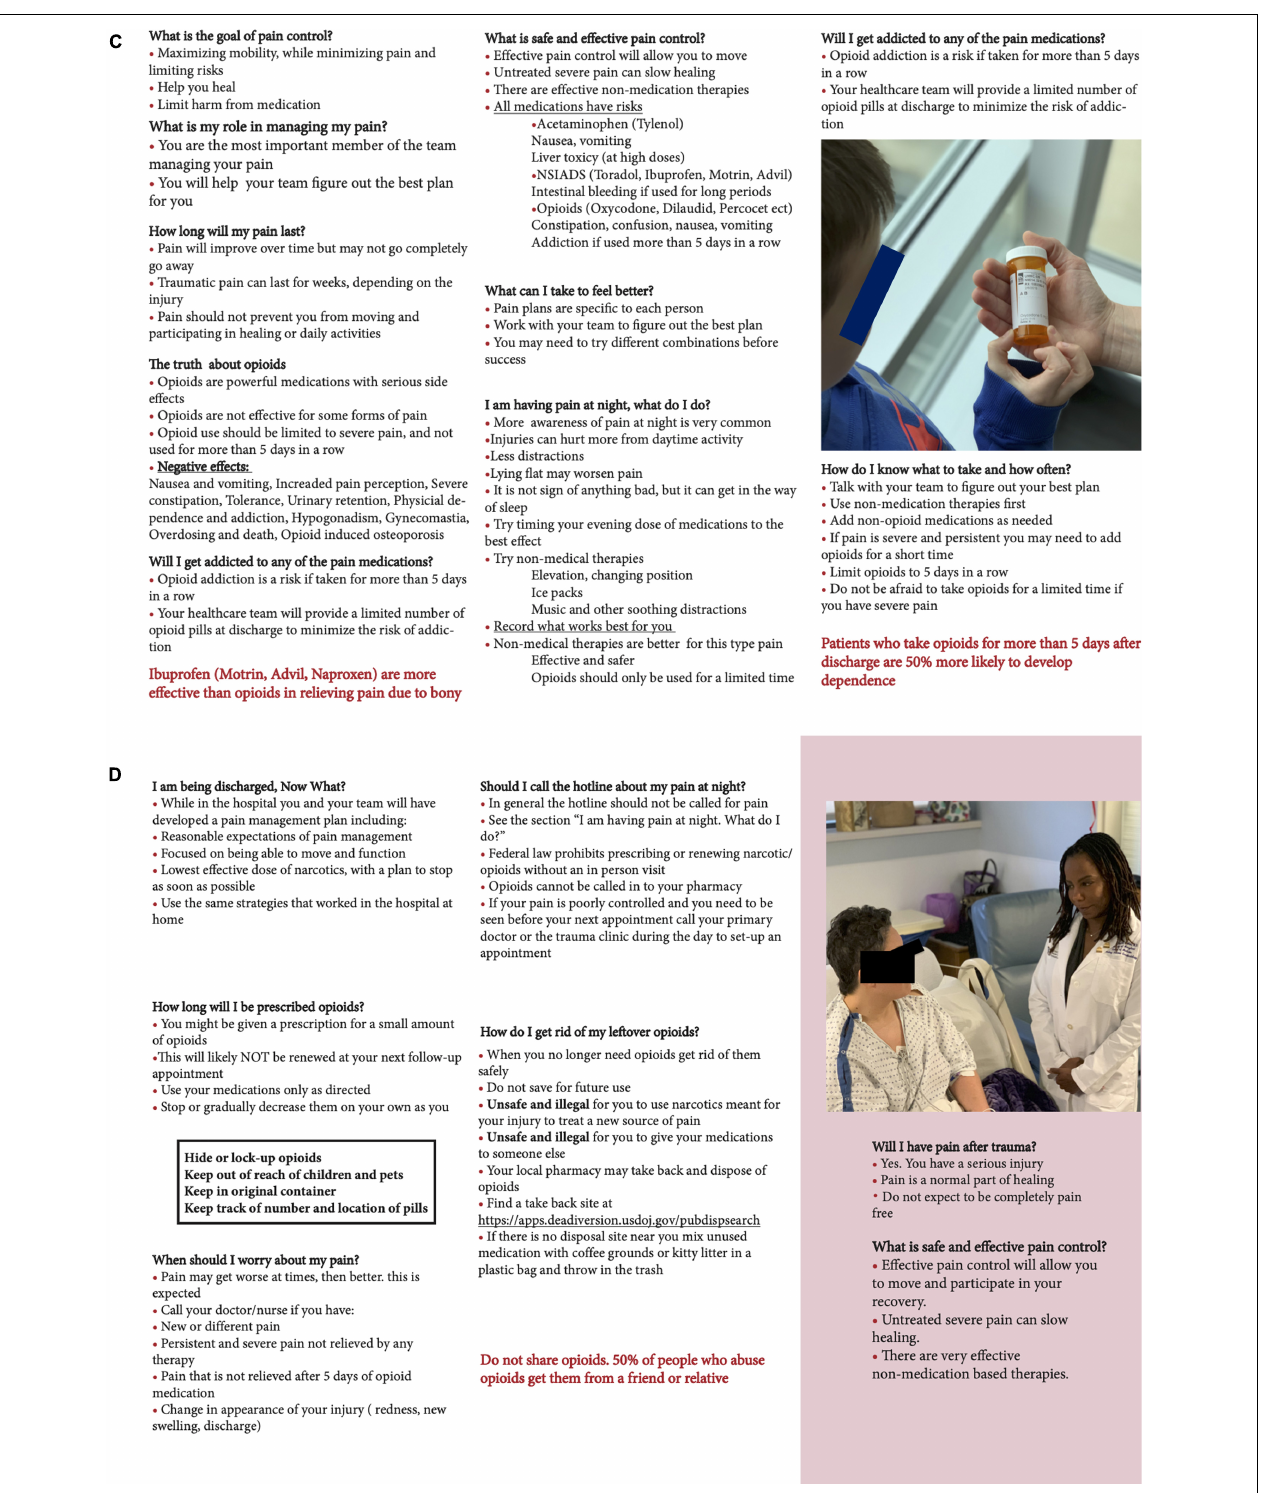
FIGURE 2 | Educational intervention brochure. It started with a recovery guide that aimed to maximize patient recovery by explaining the pain interference (“How is my function?”) and the pharmacological and non-pharmacological therapeutic options (“What can I take to feel better?”) (A) . The educational brochure provided then a list of the most common therapies to improve functions (B) . The remainder of the educational materials had commonly asked questions and answers to topics specific to pain control goals, duration of pain, and risks of addiction development (C,D) .